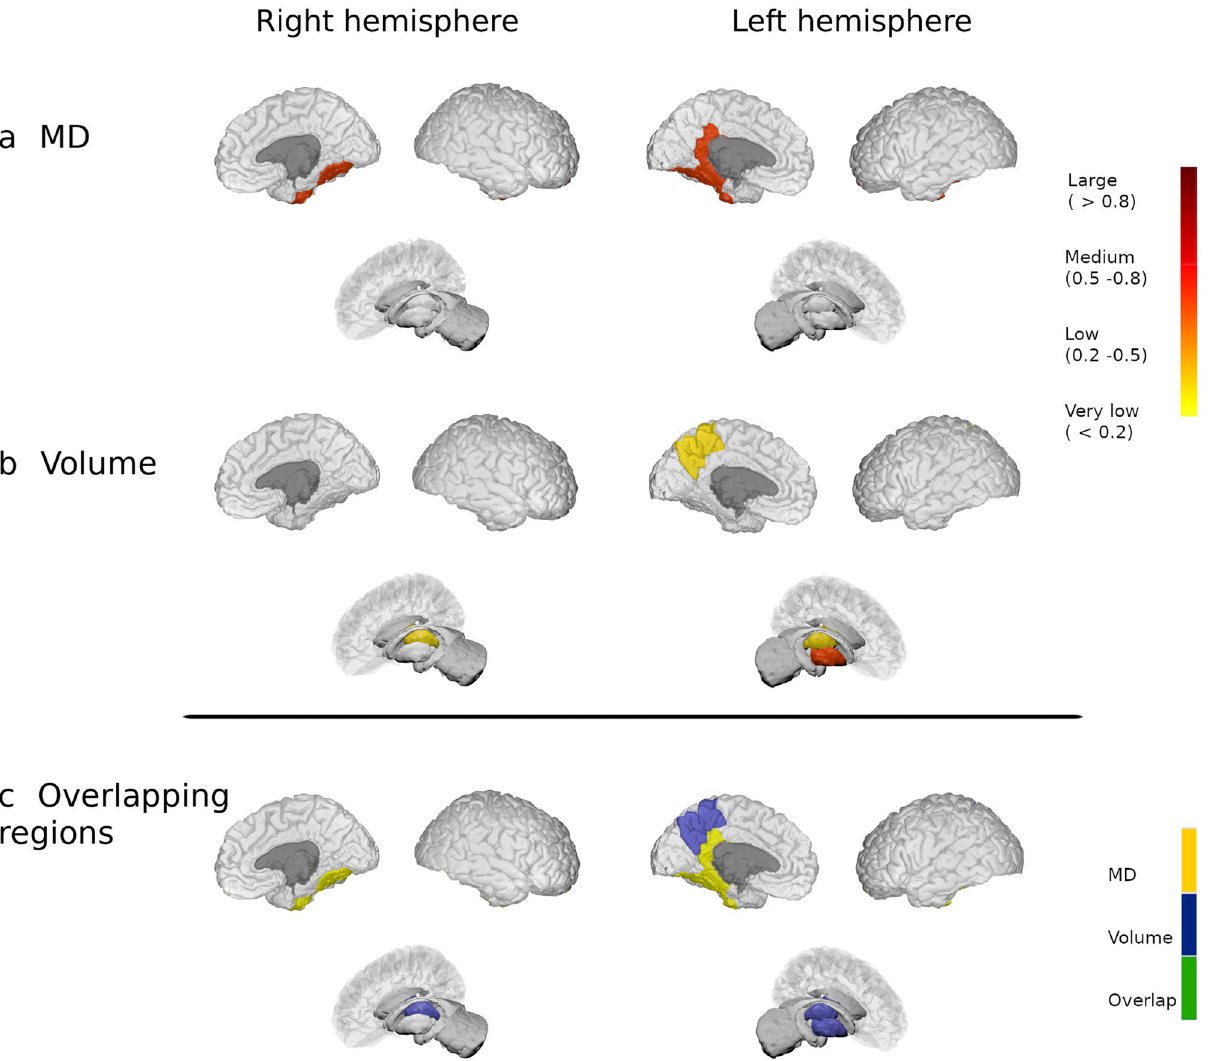
Figure 1. Modifications in patients with less than 5 years of disease duration. Differences in the grey matter mean diffusivity ( a ) and in volume ( b ) between patients from the MS1 group and HC. The colour gradient from yellow to red indicates the effect size ranges. The bottom figure shows the changes in MD (in yellow), volume (in blue) and their overlap (in green). The figure was generated using BrainPainter software 50 In the MS2 group, MD increased in 14 regions (18.4%) relative to the HC, in which most of the regions showed a medium effect size. The largest differences between these groups were evident in areas like the bilateral cingulate, left insula and left parietal cortex (corrected p < 0.05). Meanwhile, FA showed low effect size differences between groups, with increased FA in the bilateral putamen and left parietal cortex (corrected p < 0.05). In addi- tion, in this group of patients, there was a volume decrease in 19 regions (25%) mainly involving bilateral nuclei of the deep GM and left parietal cortex (corrected p < 0.05: Fig. 2 and Supplementary Fig. 2). And finally, in the MS3 group, there were 64 regions (84.2%) that showed widespread medium-to-large increase in MD relative to the HC, mainly in the cortex (corrected p < 0.05), while MD in the right pallidum was dampened (corrected p = 0.001). FA increased in 21 regions (27.6%) involving areas from the bilateral frontal, parietal cortex, and deep GM compared to HC, whereas FA was reduced in the bilateral insula and hippocampus, and also in the left isthmus of the cingulum (corrected p < 0.05). Almost all differences had a medium effect- size. Additionally, patients of the MS3 group showed a diffuse reduction in GM volume in 69 regions (90.8%). Bilateral areas involving the insula, frontal and parietal, and right occipital regions displayed the strongest dif- ferences between groups (corrected p < 0.05: Fig. 3 and Supplementary Fig. 3). Exploring the differences between the older subgroup of HC (47.1 ± 5.7 years, n = 28 subjects) and MS3 (50.2 ± 8.0 years, p = 0.063), we found that patients with MS had a higher MD in 63 GM regions (82.9%), higher FA in nine (11.8%) and reduced FA in four (5.3%). Also, patients had widespread reduced volume in 62 nodes (81.6%) throughout the cerebral cortex (corrected p < 0.05), similar to the results with the whole HC cohort. Additionally, when we excluded patients with a secondary progressive (SP) MS from the analysis, the results only showed minor modifications. Thus, the